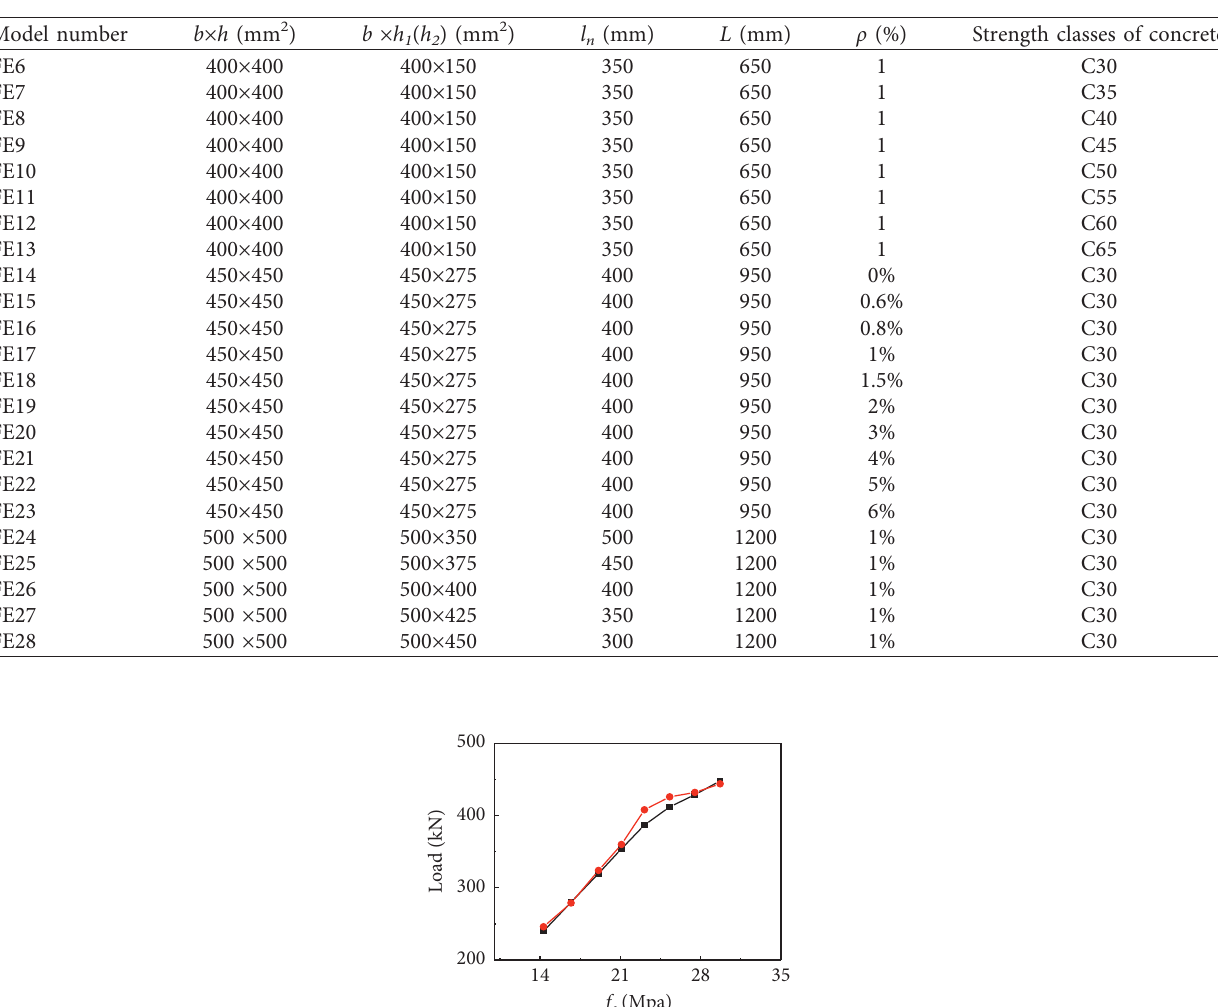
Table 7: Parameters of FE models.